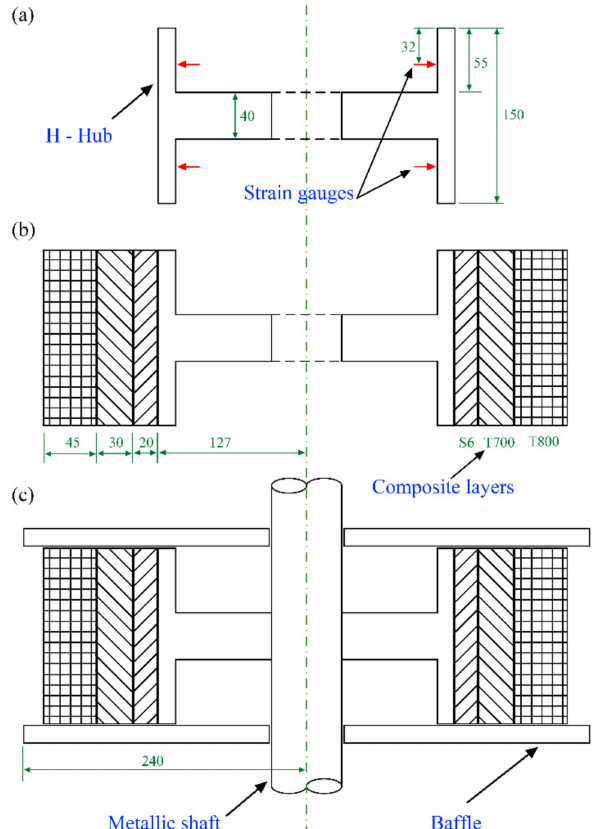
Figure 2. Diagram of flywheel rotor: ( a ) dimension of H-shaped hub and position of strain gauges; ( b ) dimension of composite layers; and ( c ) diagram of